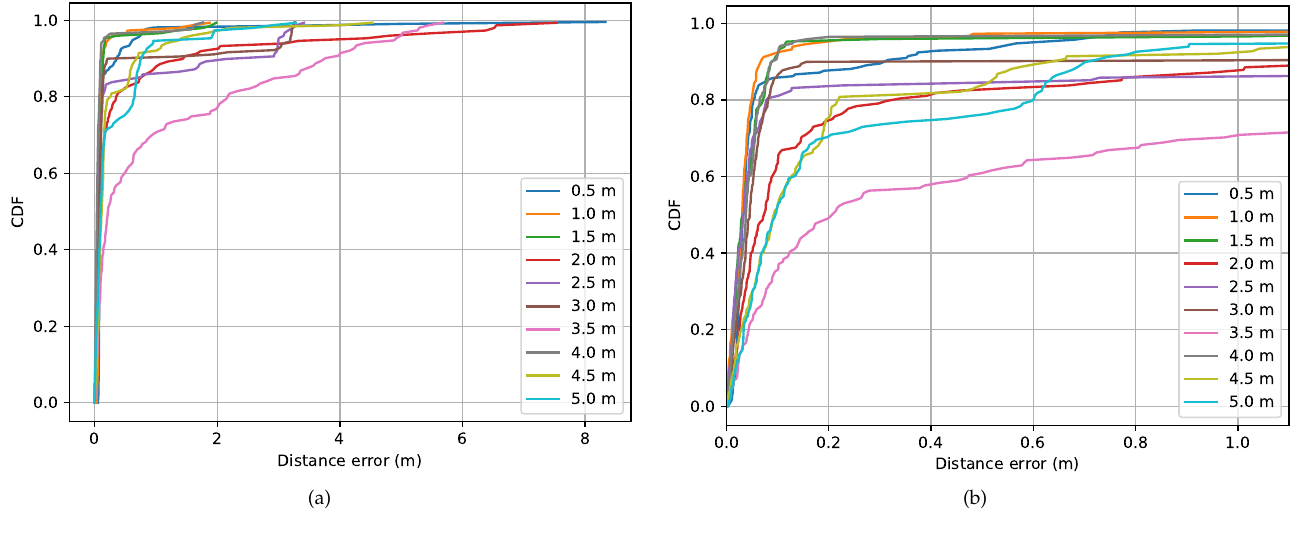
Figure 10. ( a ) General acoustic CDF plot of the measured distance error for different inter-speaker and backscatter distances; and ( b ) detail of the general acoustic CDF plot for distance errors smaller than 1m. Table 3. Metrics overview of the acoustic